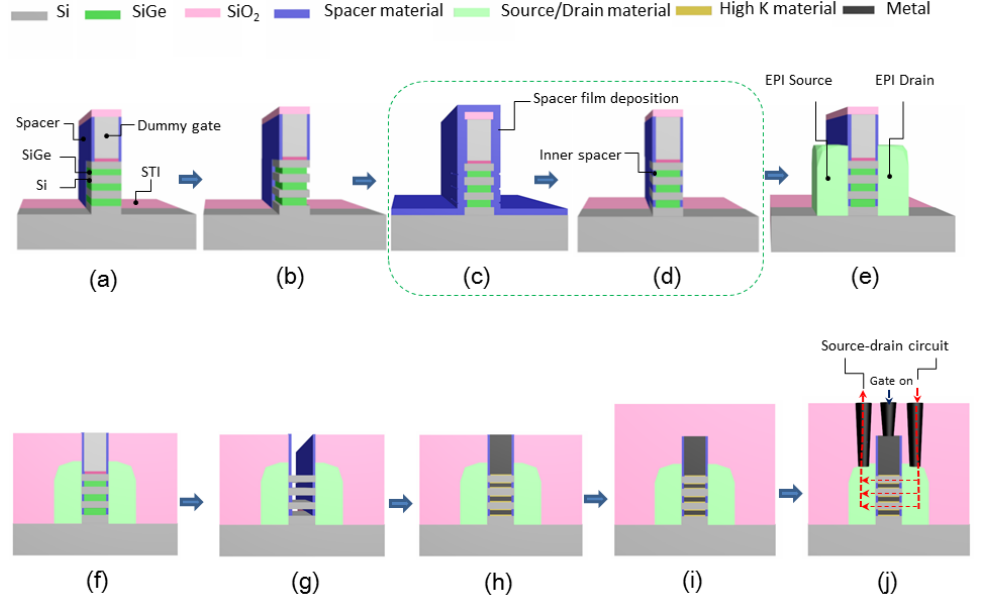
Figure 1. Process flow of nanowires with inner spacer: ( a ) source/drain Fin recess for opening active area; ( b ) SiGe cavity etching for defining the growth position and size of the inner spacer; ( c ) inner spacer film deposition; ( d ) controlled etching of spacer film and formation of inner spacer; ( e ) source and drain epitaxial growth; ( f ) dielectric deposition and planarization; ( g ) dummy gate removal and silicon nanowires formation; ( h ) filling and planarization of high-K metal gates; ( i ) interlayer dielectric deposition; ( j ) metal contact plug and current direction when device is on.